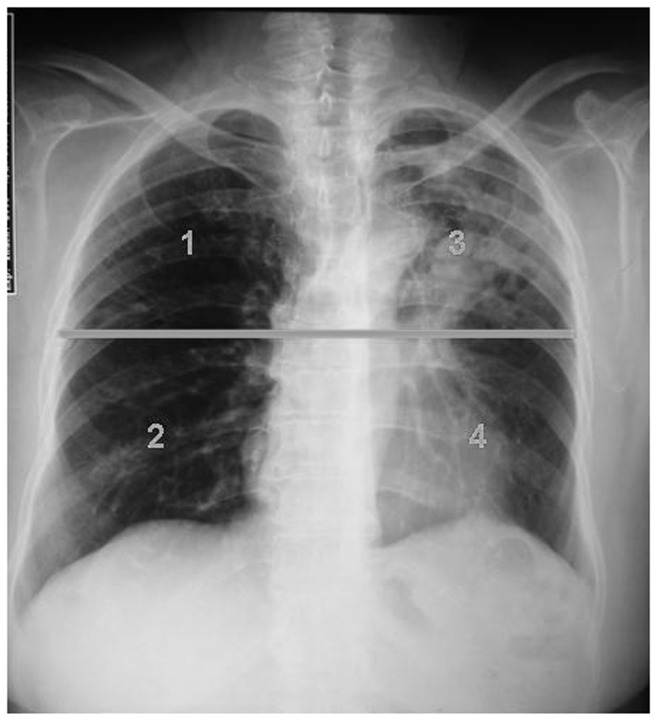
Representative example of the result of the scoring system for radiographic abnormalities.Score =6.5, which represents the mean value of two evaluations.